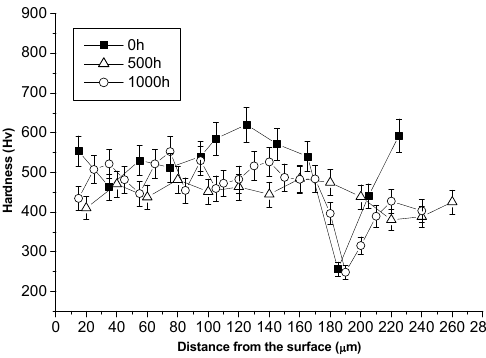
Figure 9. Micro ‐ hardness profiles of HVOF sprayed CoNiCrAlY on IN738 + heat treatment at 0, 500 and 1000 h of isothermal test.